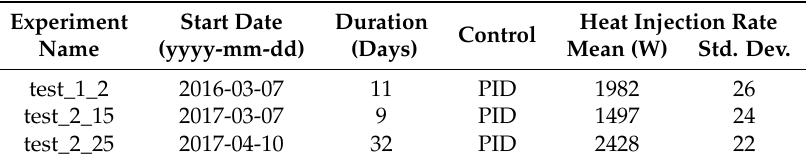
Table 2. Brief description of included